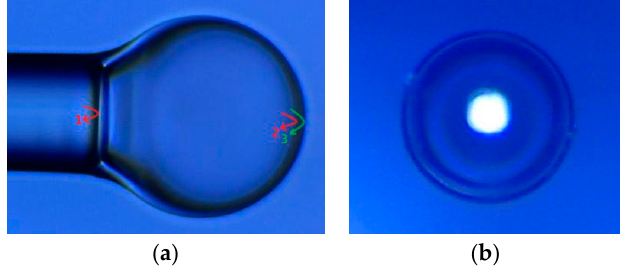
Figure 2. ( a ) Microscope image of the micro bubble; ( b ) Top view of the micro bubble.